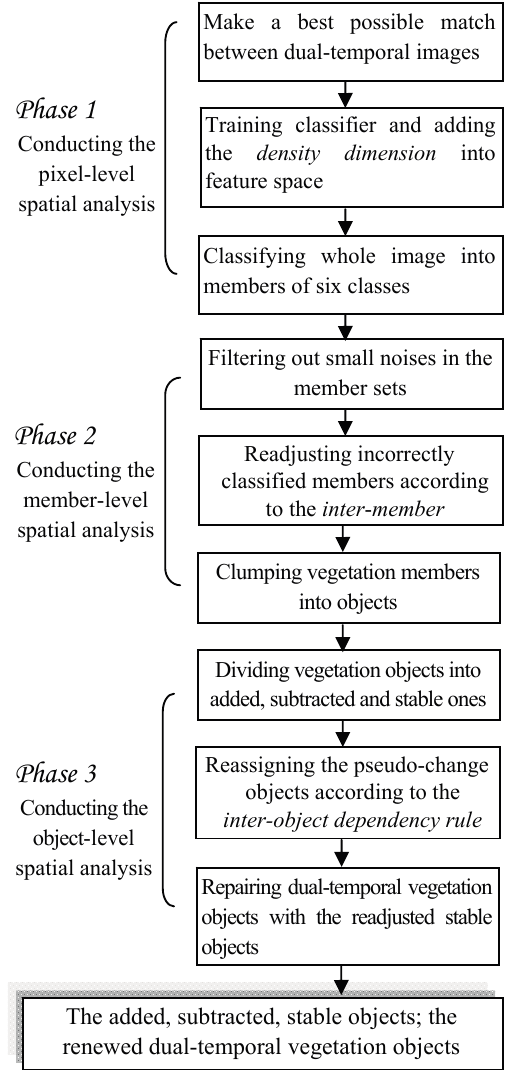
Figure 2. The flowchart of the multi-level spatial